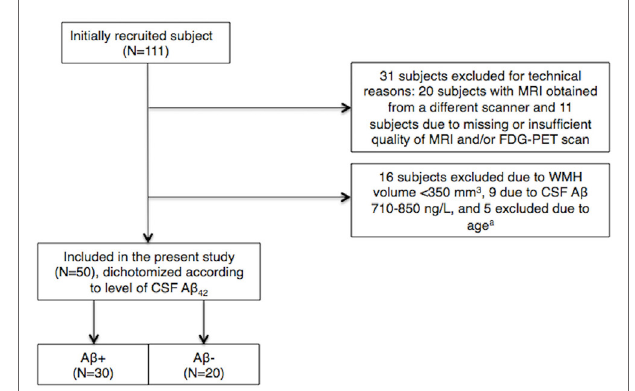
FigUre 1 | inclusions and exclusions in the cohort . a 5 subjects of > 73 or < 44 years of age were excluded to limit between-group age differences. CSF, cerebrospinal fluid; A β , amyloid β -peptide; WMH, white matter